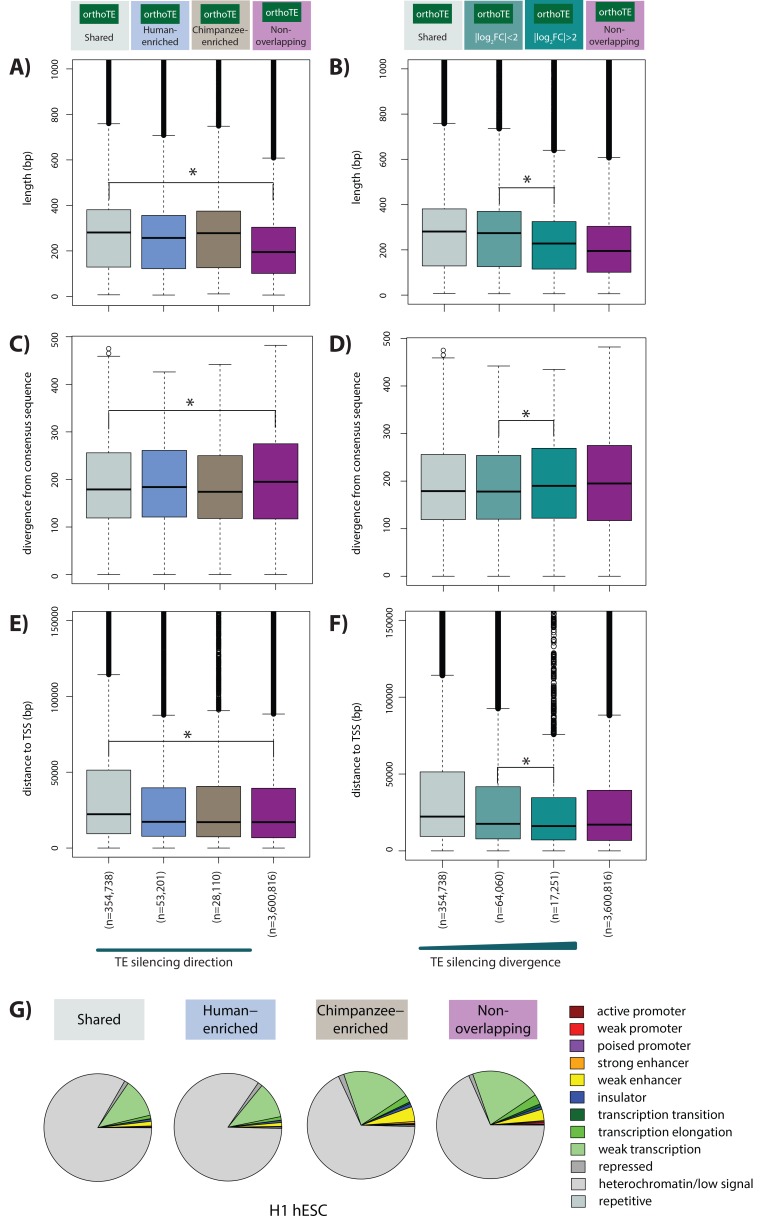
Majority of silenced orthologous TEs have similar properties in humans and chimpanzees.(A) The length of all orthologous TE instances occurring within Shared, Human-enriched and Chimpanzee-enriched H3K9me3 silencing categories. (B) The length of all orthologous TEs stratified by inter-species divergence in effect size. (C) The sequence divergence from the consensus TE sequence of TEs categorized as in (A). (D) The sequence divergence of TEs categorized as in (B). (E) The distance between each TE and the closest orthologous TSS categorized as in (A). (F) The distance between each TE and the closest orthologous TSS categorized as in (B). Grey: Shared, blue: Human-enriched, brown: Chimpanzee-enriched, magenta: does not overlap an orthologous H3K9me3 region, light teal: log2 fold change less than two between species, dark teal: log2 fold change greater than two between species. (G) Orthologous TEs categorized by silencing status that overlap chromatin states annotated in the H1 hESC line. Asterisk denotes when there is a significant difference between the Shared and Non-overlapping, and high and low divergence categories (Wilcoxon-rank sum test; p<0.001). Also see Figure 5—figure supplements 1–6.